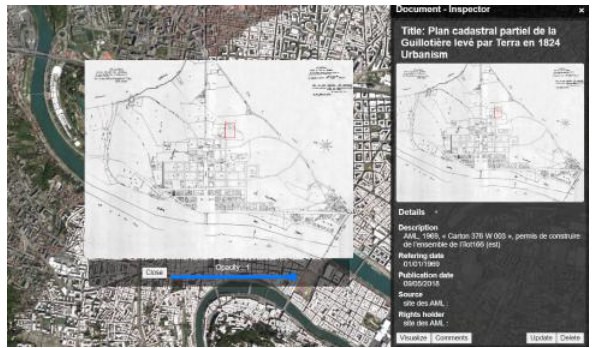
Figure 9. An historical cadastral plan is shown superimposed on top of the 3D scene by using the extended document